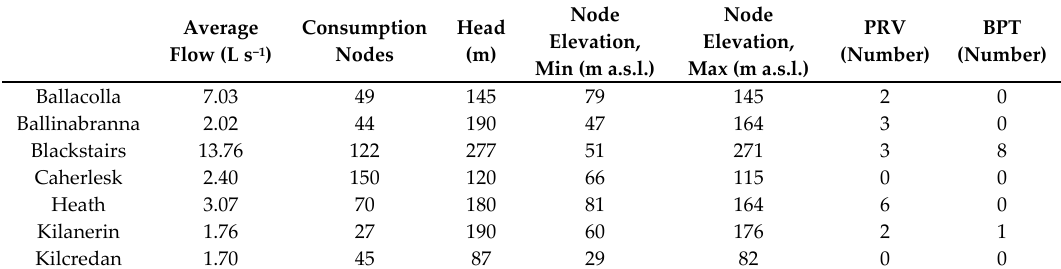
Table 1. Main data of the selected